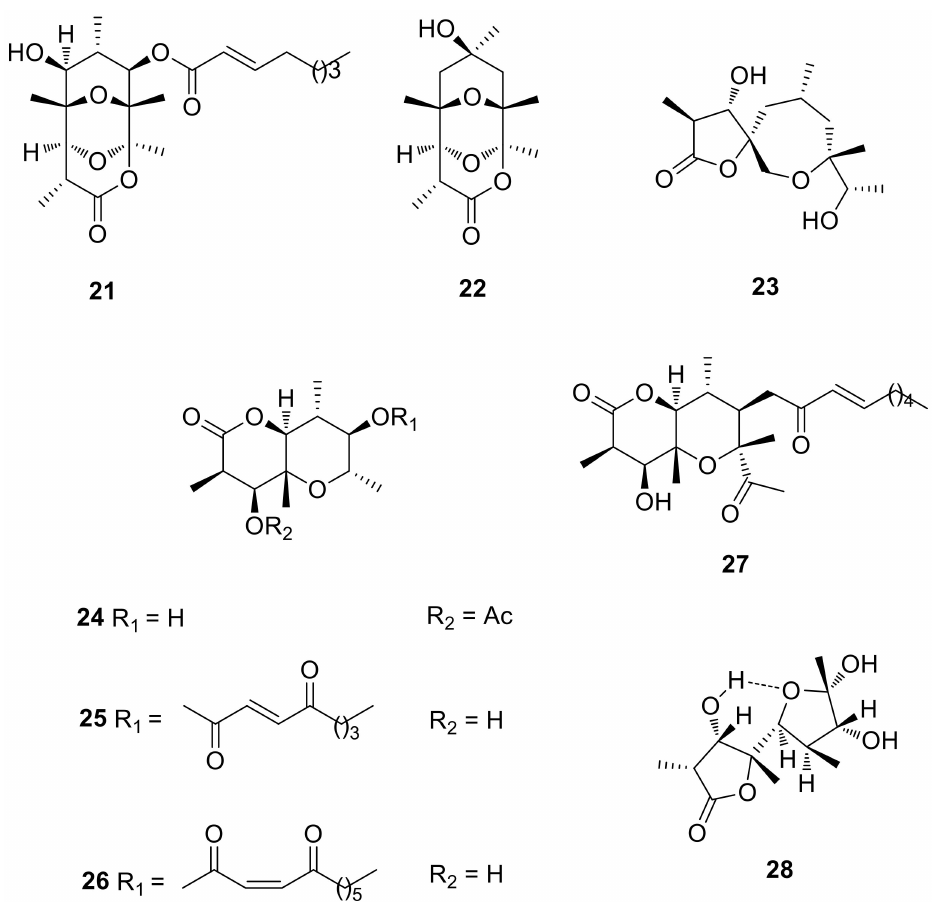
Figure 11. New polyketides isolated from Bcbot4 knock-out mutant